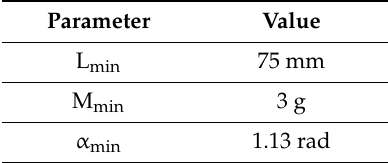
Table 2. The initial values of the parameters used for